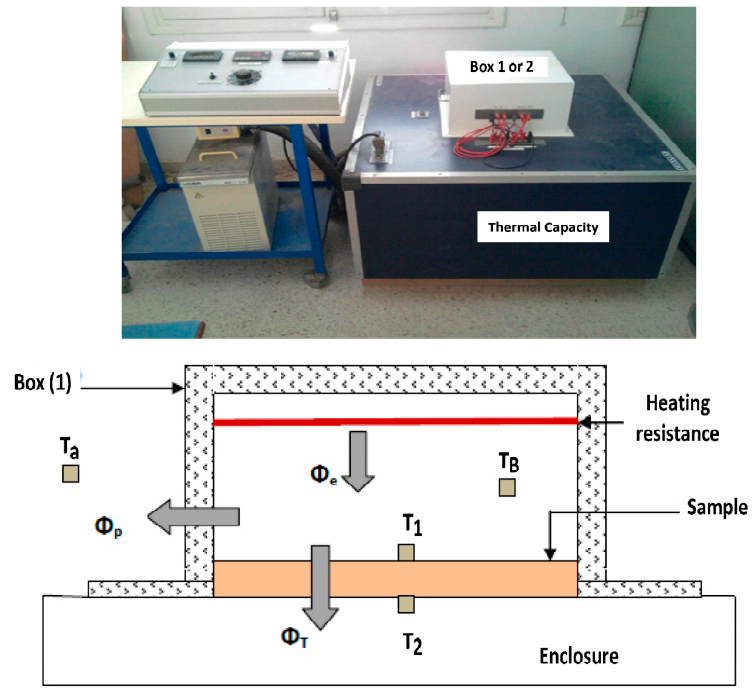
Figure 17. Thermal conductivity measurement using boxes method test [27].